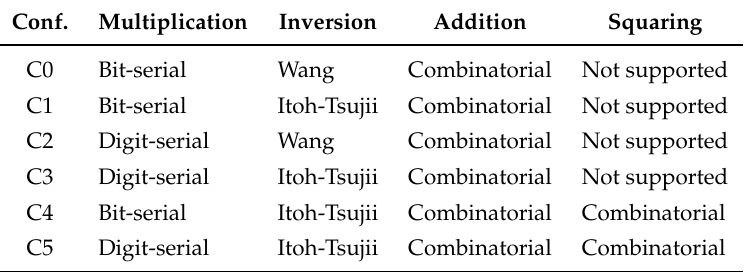
Table 7. Details of the six different kP architectures created, highlighting the approach used for performing field